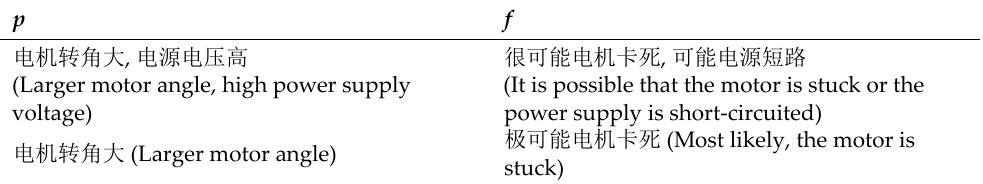
Table 6. The rules set.